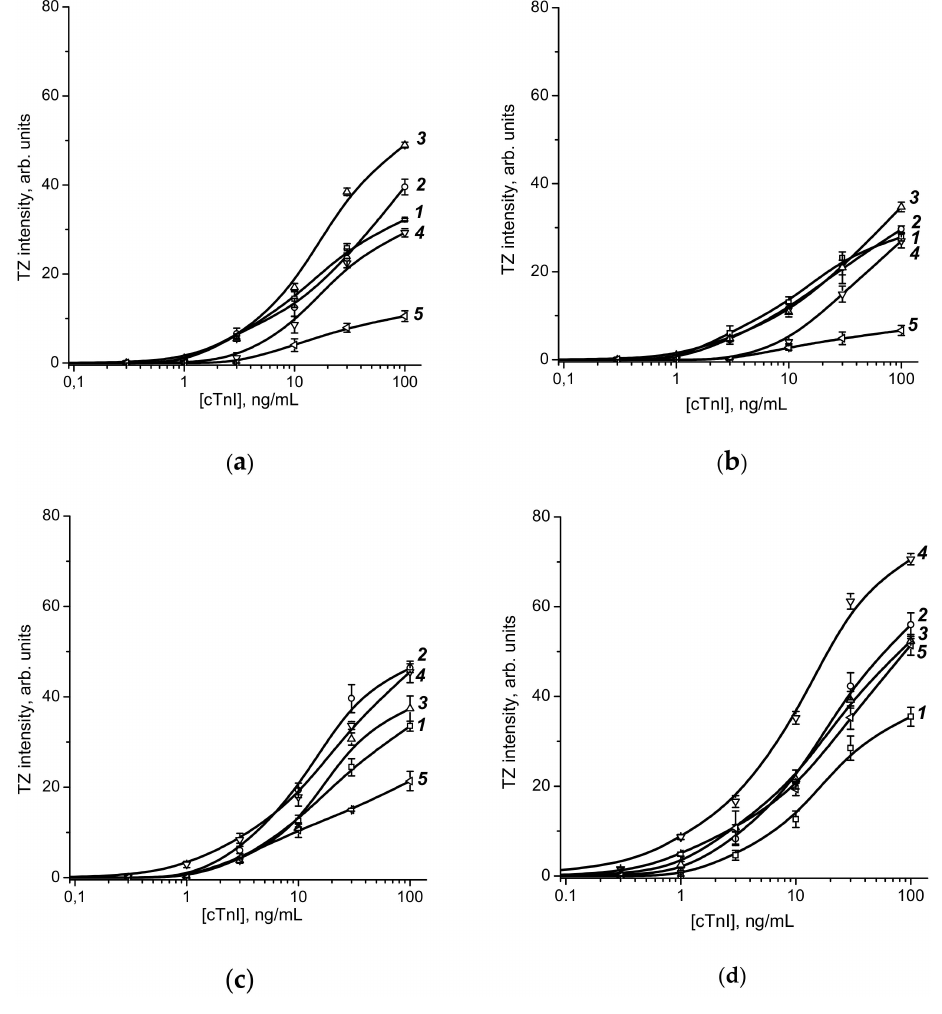
Figure 2. Dependencies of the intensities of staining of the test zone on the concentration of antigens in the sample for conjugates C-GNPs-1–C-GNPs-5 ( a , b ) and S-GNPs-1–S-GNPs-5 ( c , d ) during adsorption ( a , c ) and covalent ( b , d ) immobilization of antibodies. All measurements were performed in